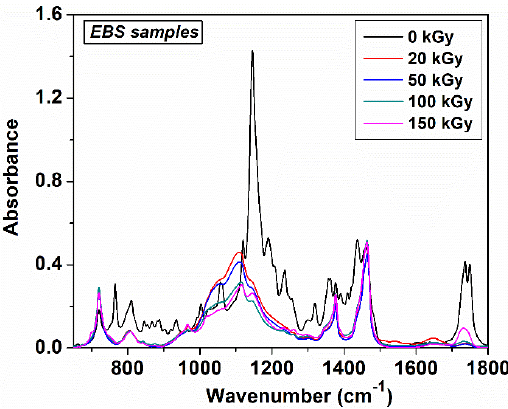
Figure 9. FTIR spectra of electron beam irradiated E-B-S composites at different irradiation doses.